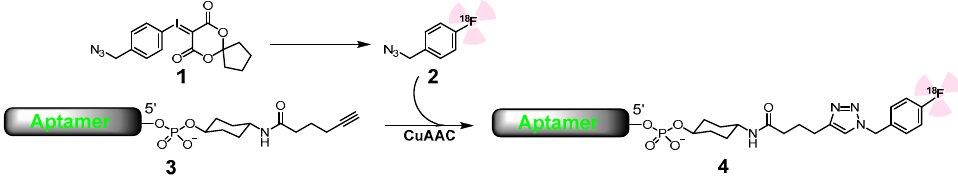
Figure 2. Preparation of the aptamer conjugates using 4-[ 18 F]fluorobenzylazide by the CuAAC method with/without TBTA ( 1 -spyrocyclic iodonium ylide precursor, 2 -4-[ 18 F]fluorobenzylazide, 3 -5 ′ -alkyne-modified aptamer, 4 -radioactive conjugate).